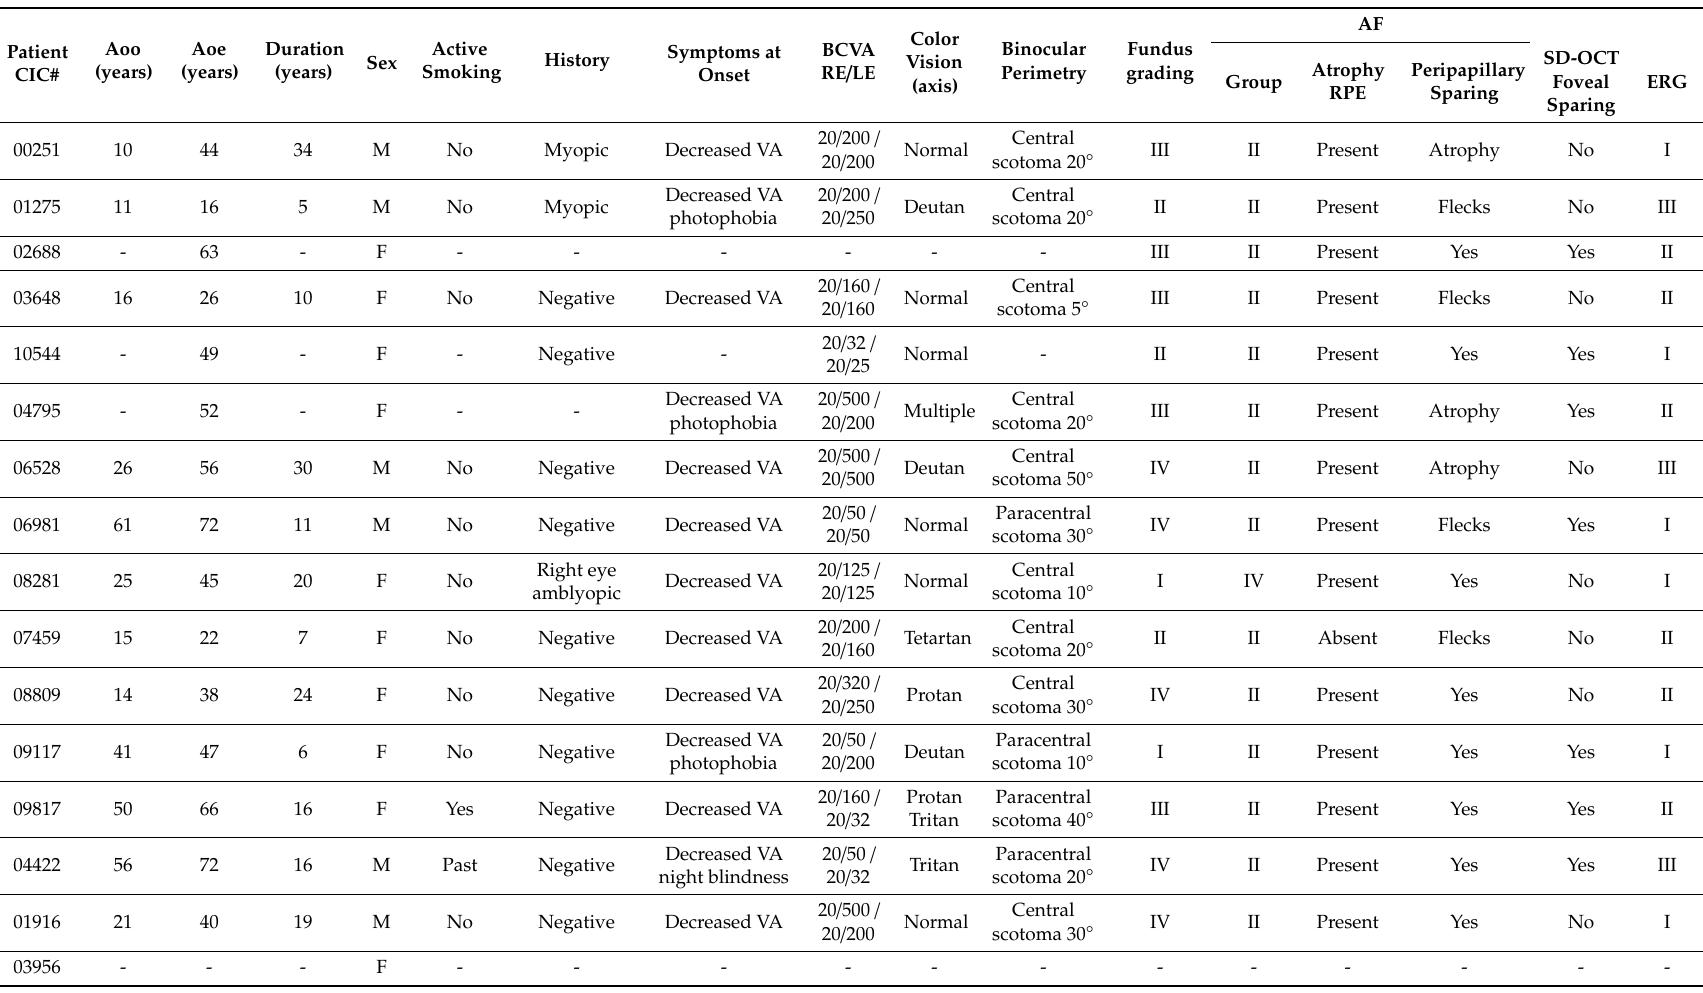
Table 3. Retrospective data collection of the phenotype of the subject harboring a deep-intronic variant in ABCA . Aoo: Age of onset; Aoe: Age at the time of examination; BCVA: best corrected visual acuity: RE: right eye; LE: left eye; AF: autofluorescence; OCT: optical coherence tomography; ERG: electroretinogram; RPE: Retinal pigment